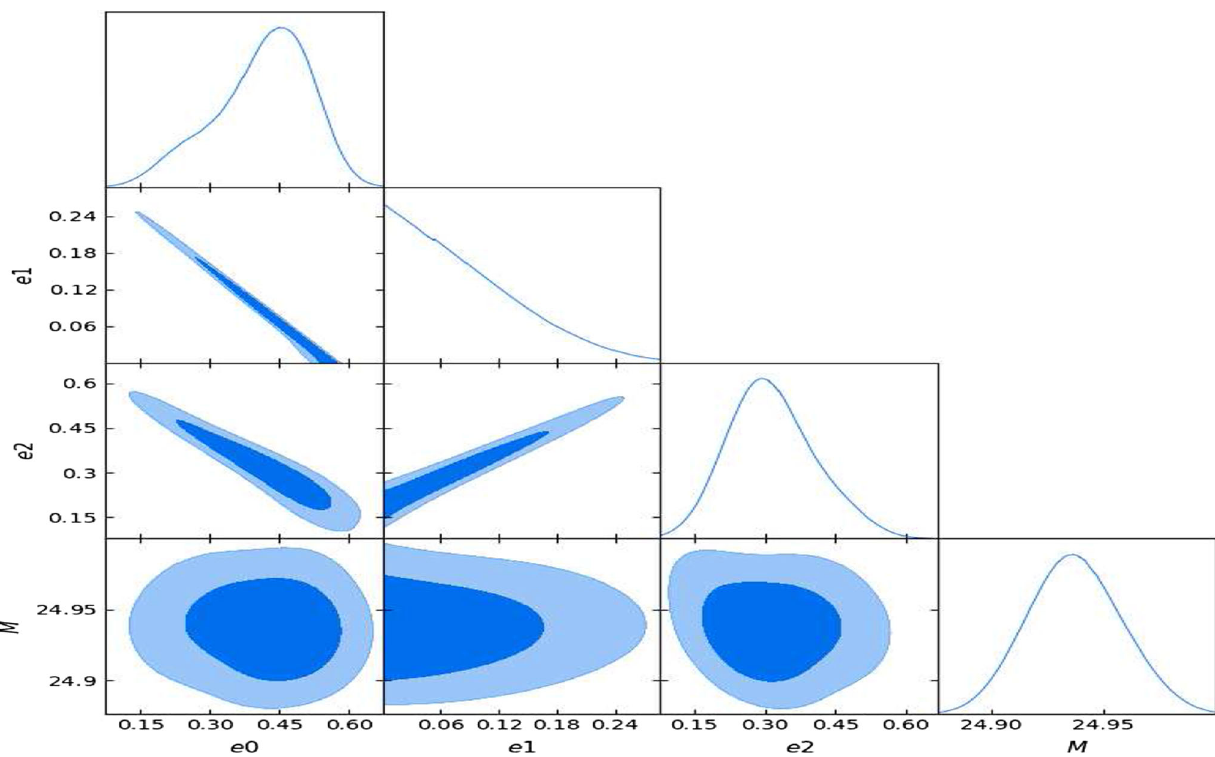
Fig. 3 The contour map of matter creation model based on joint analysis of SNe + BAO showing contours of 1 σ( 68 . 3% ) and 2 σ( 95 . 4% ) regions with marginalized probability for the parameters. In Fig. the symbols e 0, e 1 and e 2 denote the model parameters α , β and γ ,